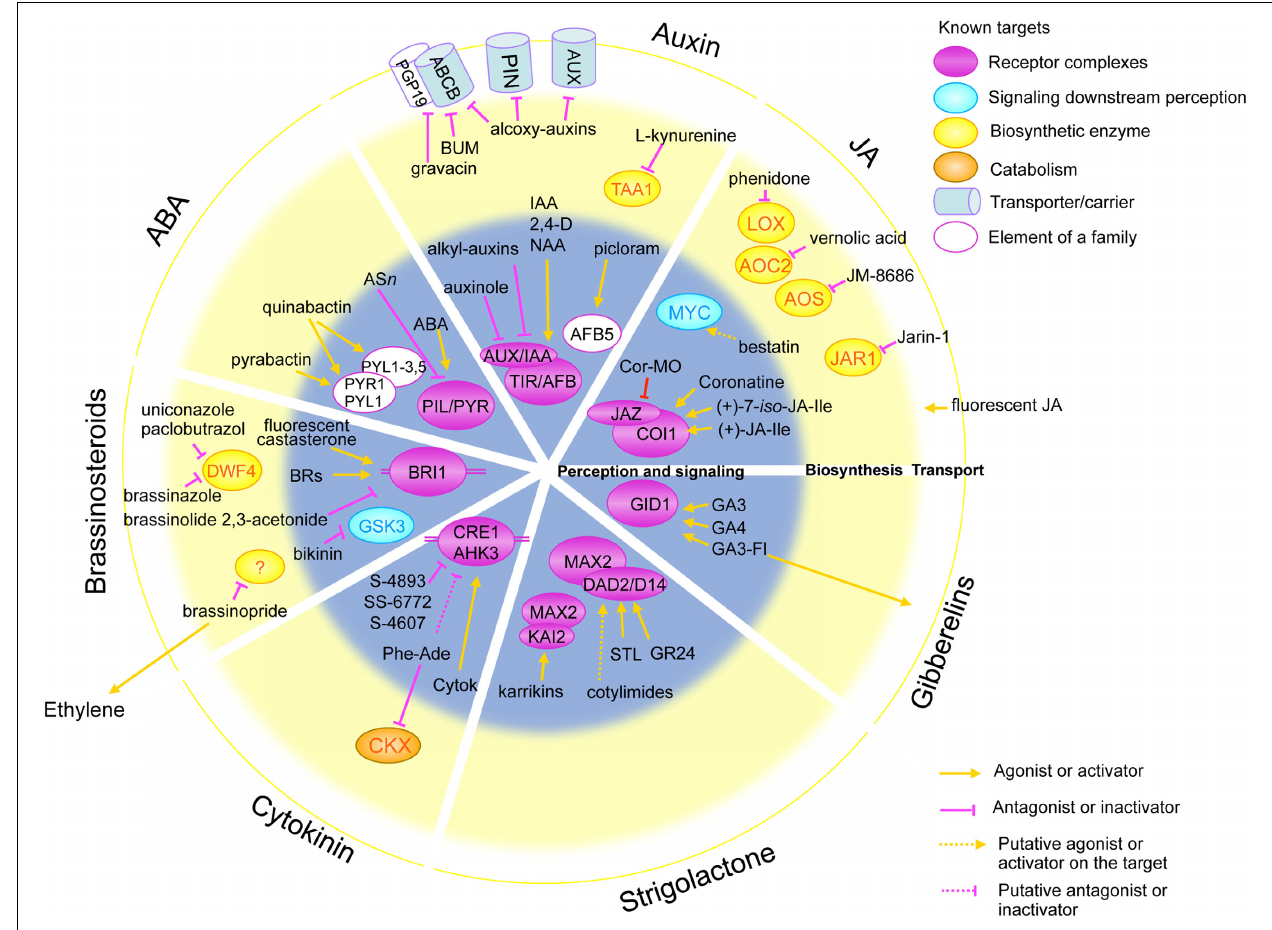
FIGURE 1 | Schematic representation of the molecular targets of small molecules acting in different hormonal pathways. Concentric circles in the background represent the distinct biological processes in hormonal pathways: perception and signaling (gray inner circle), biosynthesis (yellow middle circle) and transport (white outer circle). Circles are divided in quadrants for distinct hormones, from the top clockwise: auxin, jasmonic acid (JA), gibberellins,